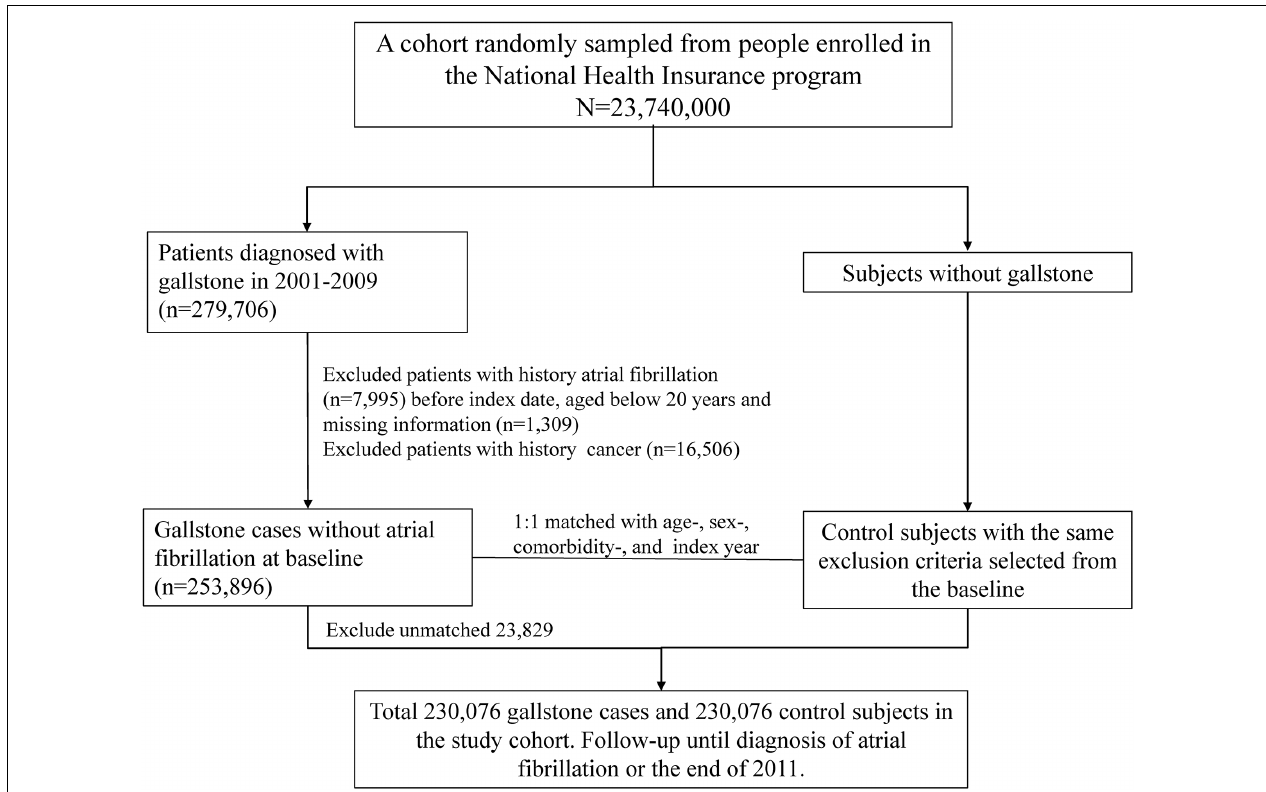
FIGURE 1 | Flowchart for study population